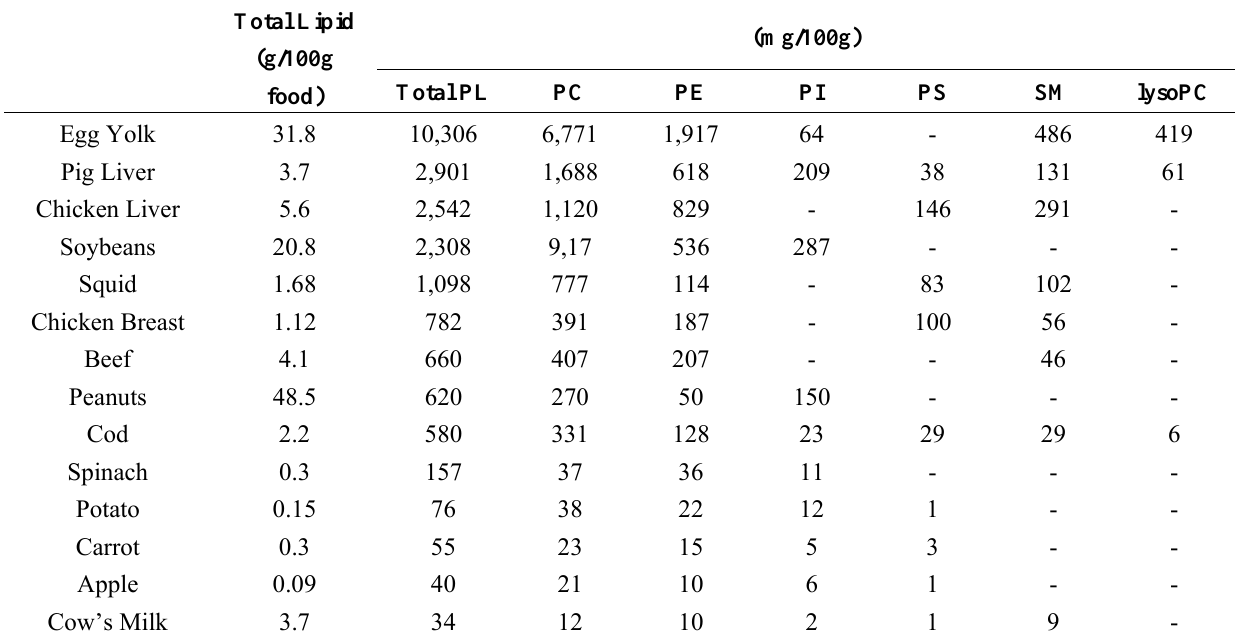
Table 1. Total lipid and phospholipid content of specific